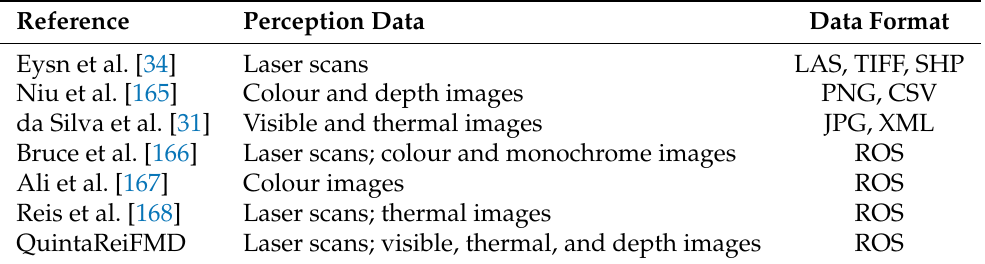
Table 6. Summary of works presenting perception datasets in forests and our dataset, as well as their